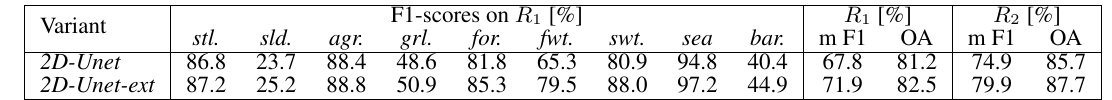
Table 3. Evaluation of land cover classification with mono-temporal and multi-temporal input data based on 2D convolutions. F1-scores on R 1 [%] R 1 [%] R 2 [%] Variant stl. 3D-2D-Unet t 3D-Unet t 87.0